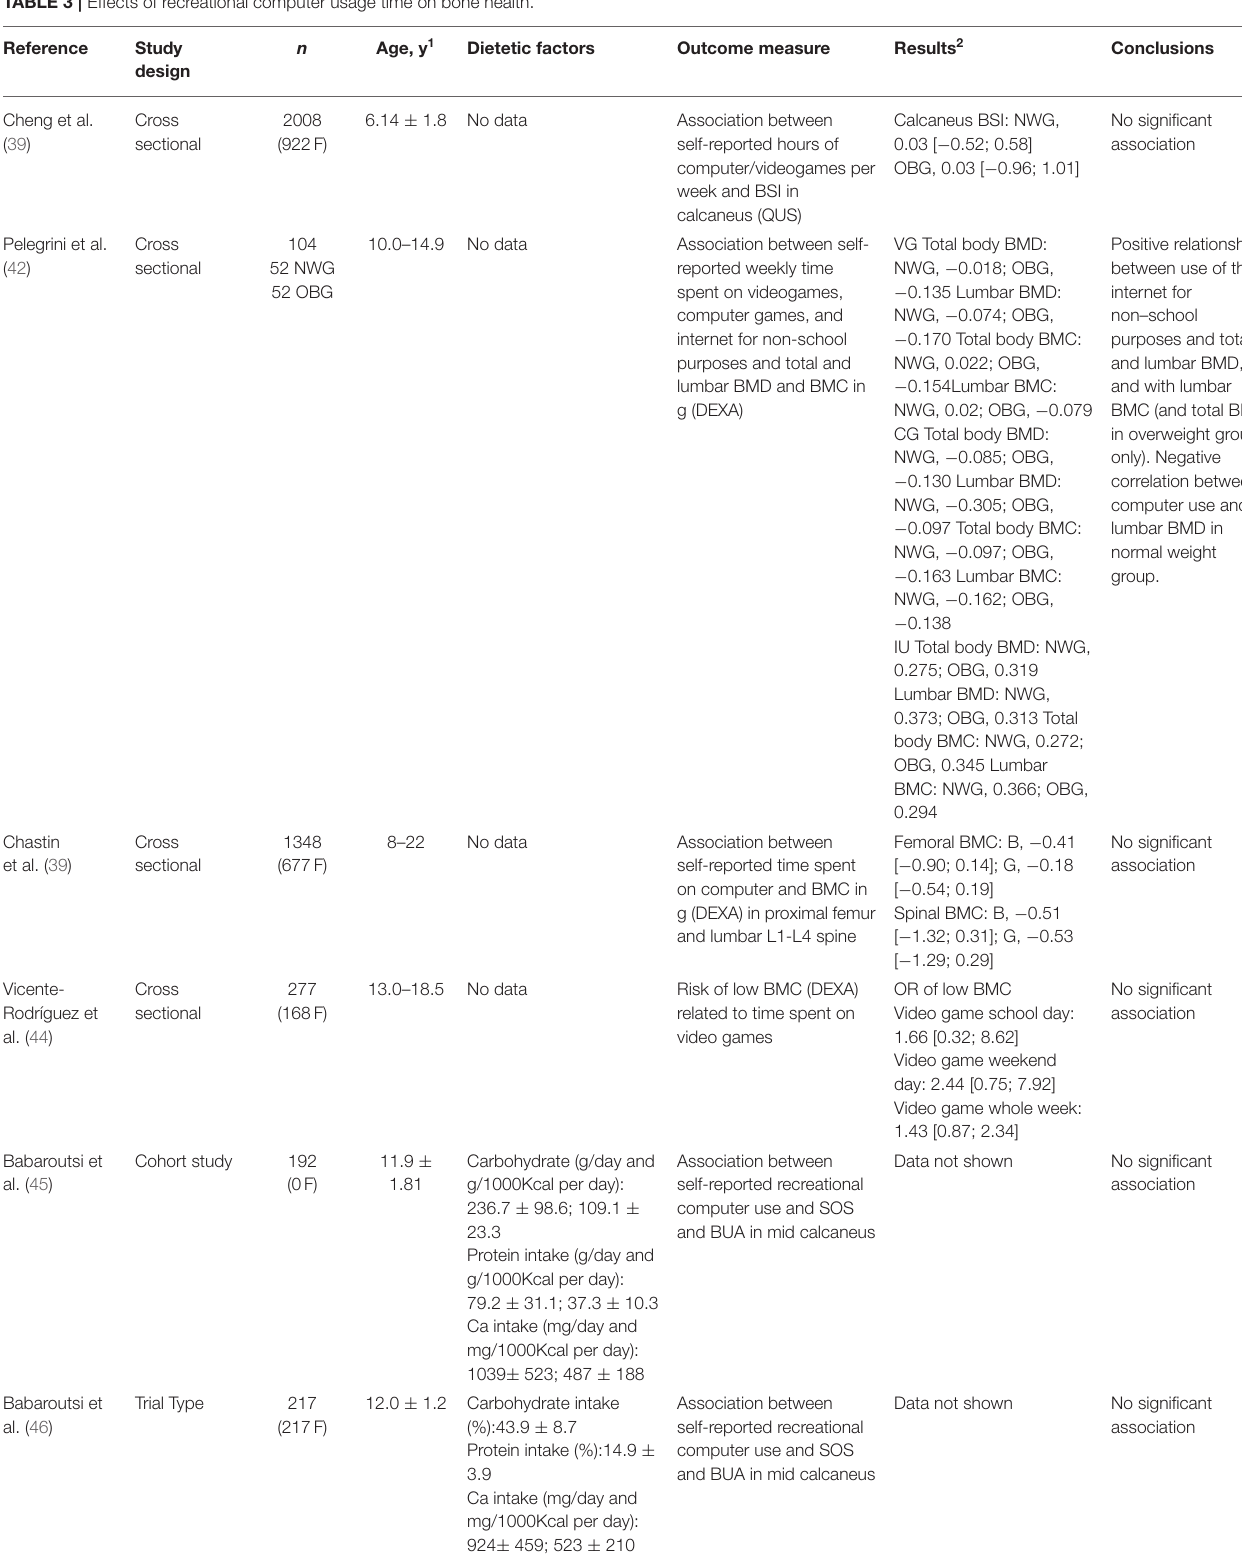
TABLE 3 | Effects of recreational computer usage time on bone